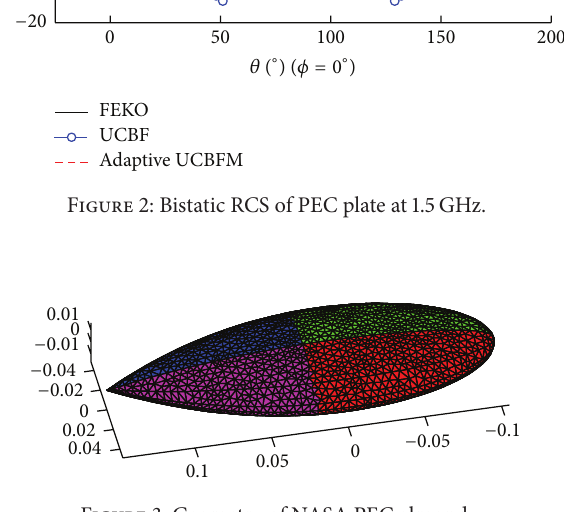
Figure 3: Geometry of NASA PEC almond. Table 2: Number of the UCBFs of the